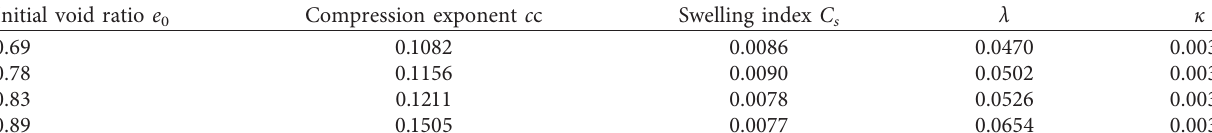
Table 7: Compression index of coral mud.